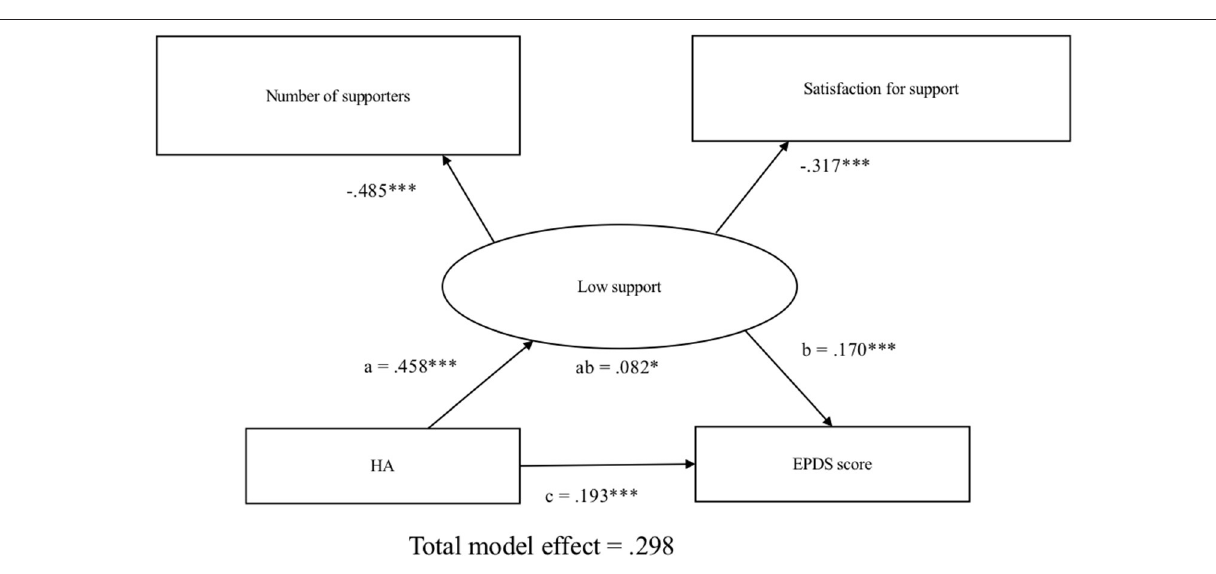
FIGURE 2 | Structural equation modeling of harm avoidance, social support, and postpartum depressive symptoms. Observed measures are represented by squares and latent variables are represented by circles. Single-headed arrows (path) define causal relationships between variables. Numbers represents standardized coefficient. a, effect of HA on low support; b, effect of low support on EPDS total scores; c, direct effect of HA on EPDS total scores; ab, indirect effect of HA on EPDS total scores. HA, harm avoidance; EPDS, Edinburgh Postnatal Depression Scale. * P < 0.05, ** P < 0.01, *** P <